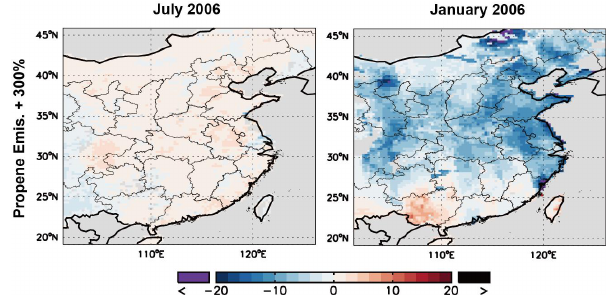
Fig. 12. 2 Fig. 12. Spatial distribution of percentage differences between modeled NO 2 columns with and without increasing emissions of propene by 300%. See Fig. S16 for more results of sensitivity tests on non-NO x